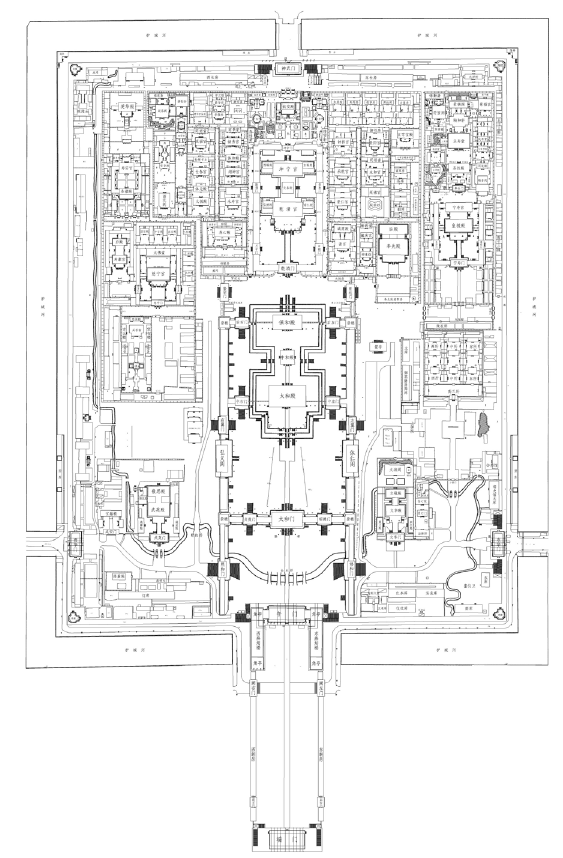
Figure 1. Plan of the Forbidden City in